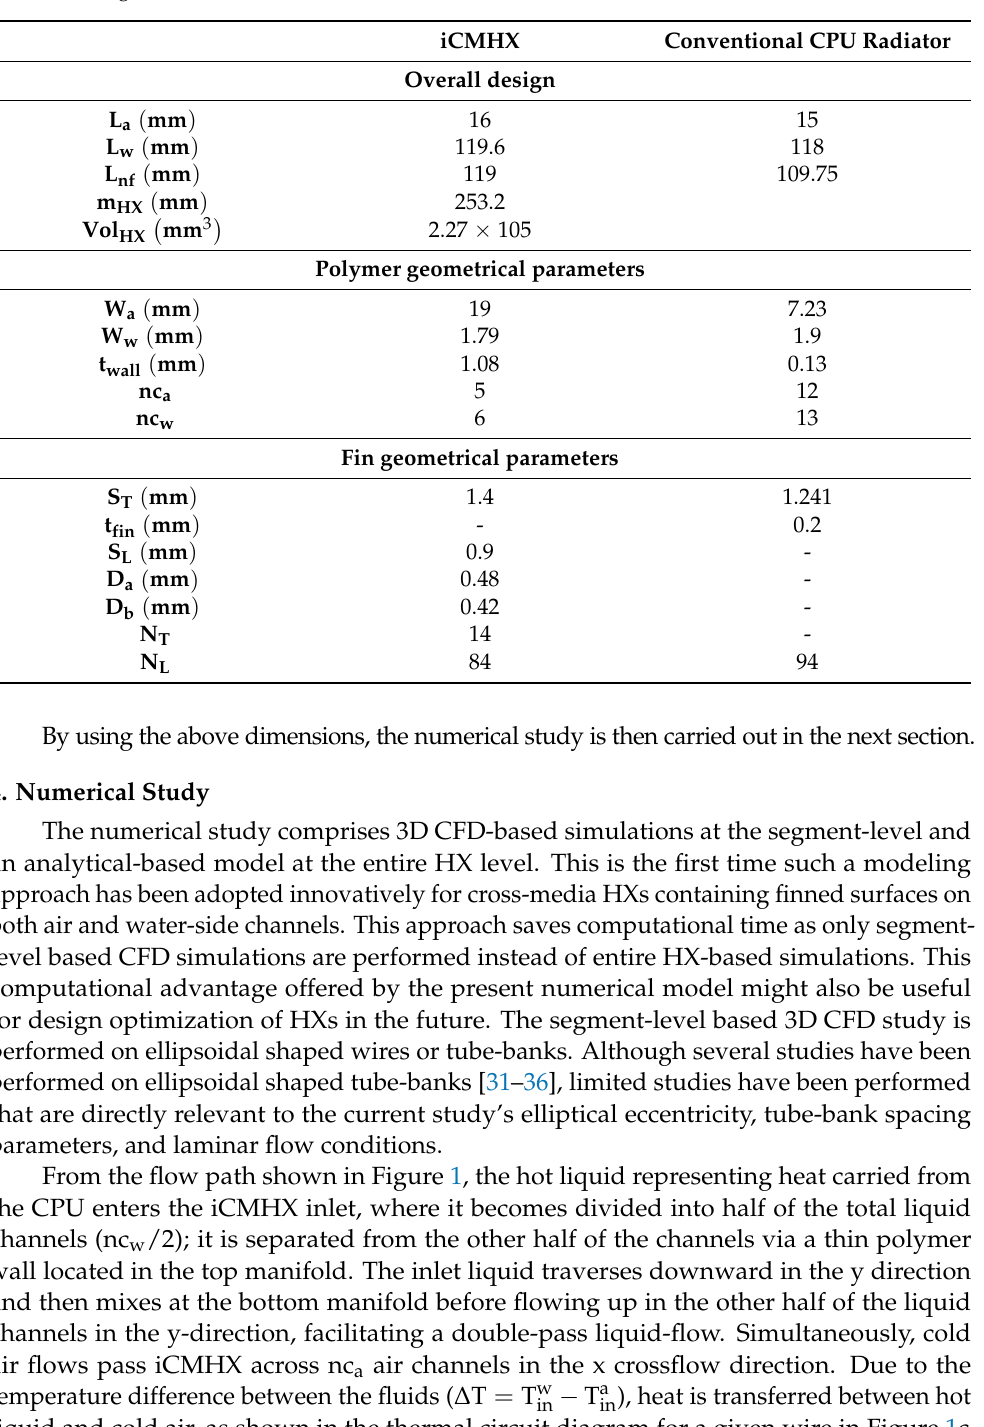
Table 5. Design details, as measured, of the current iCMHX unit and conventional CPU